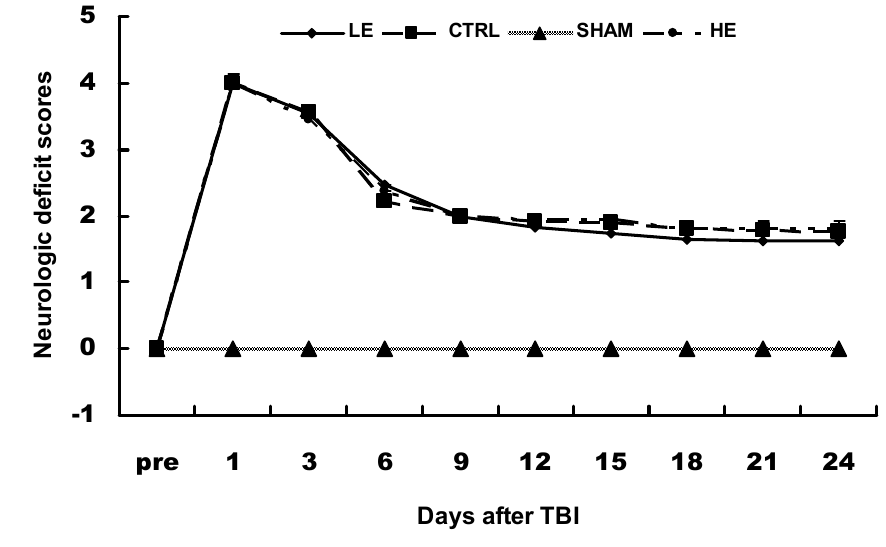
Figure 2. The effects of treadmill exercise on neurological deficit scores. The TBI rats had neurological deficit scores that decreased quickly within the first 6 days, and decreased more slowly at later time points. The TBI rats could not recover to normal at day